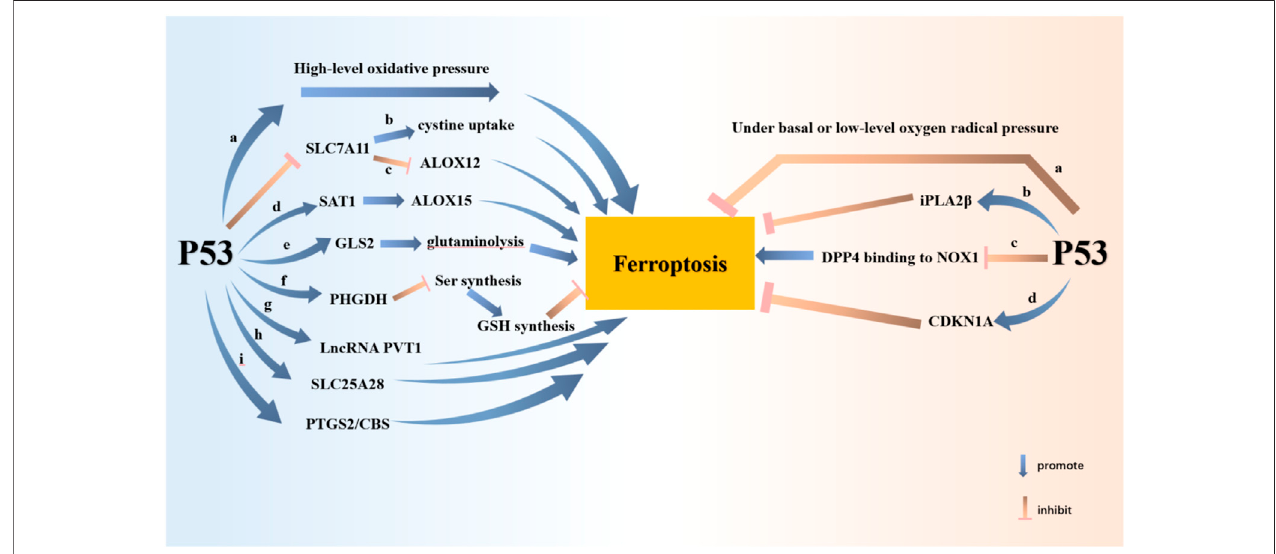
FIGURE 2 | P53 potentiates ferroptosis through nine pathways and attenuates ferroptosis through three pathways. P53 promotes ferroptosis at high levels of oxidativestress.Ferroptosis ispromotedbyP53inhibition ofSLC7A11expression. Theconsequent inhibitionofcystineuptakeandthereleaseofALOX12contributeto ferroptosis. P53 inhibits tumor cell growth by promoting SAT1-ALOX15 and GLS-glutaminolysis axes, respectively. P53 inhibits GSH synthesis through PHGDH. P53 alsopromotesferroptosisbyenhancingtheexpressionofLncRNAPVT1,SLC25A28,PTGS2andCBS.Nevertheless,P53inhibitsferroptosisatbasalorlowlevels of oxygen radical pressure. P53 inhibits ferroptosis by raising the expression of iPLA2 β and CDKN1A. P53 protects cells from ferroptosis by inhibiting DPP4 binding to